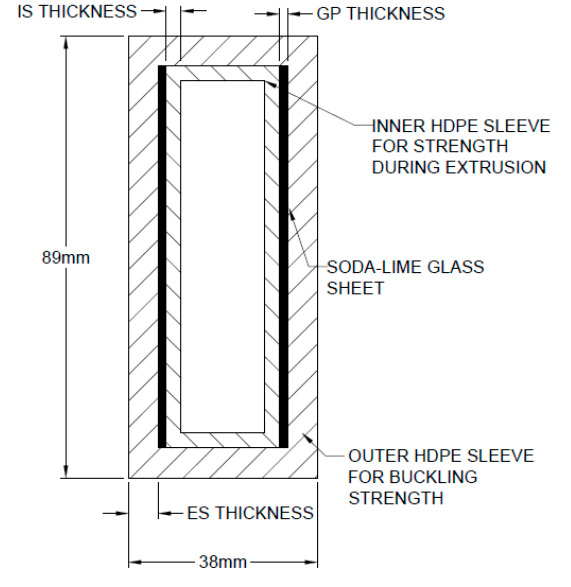
Figure 4. The general shape for the 2 × 4 replacement columns.